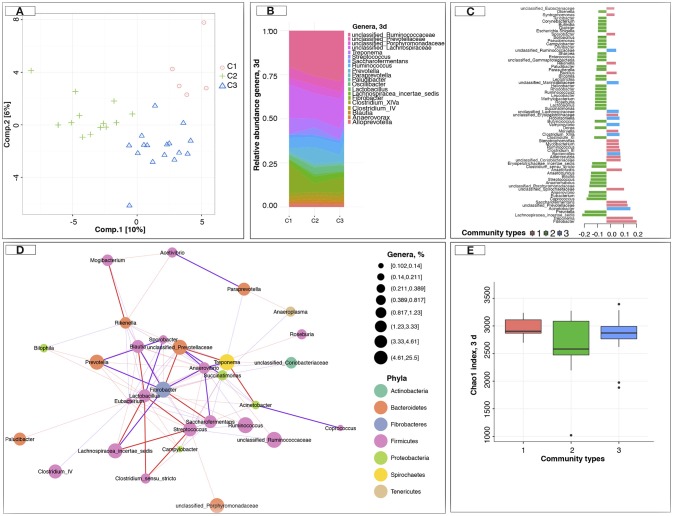
Dynamics of the gut microbiota composition at 3 days post-weaning. (A) sPLS-DA of gut microbiota composition at the level of genus at 3 days post-weaning; (B) Genera that dominant in the different gut community types at 3 days post-weaning; (C) sPLS-DA contribution plot at 3 days post-weaning, which displays the importance of each genera in the sPLS-DA model and in which gut community type they were the most abundant (contrib = “max”), according to the median (method = “median”); (D) Co-occurrence network at 3 days post-weaning. The correlations among genera were calculated using the REBECCA method (Ban et al., 2015). The size of the node is proportional to genera abundance. Node fill color corresponds to phylum taxonomic classification. Edges color represent positive (red) and negative (blue) connections, the edge thickness is equivalent to the correlation values; (E) Estimation of the Chao1 index at 3 days post-weaning between community types (or clusters). In all cases, pink color represents the community type 1, green color represents the community type 2, and blue color represents the community type 3.